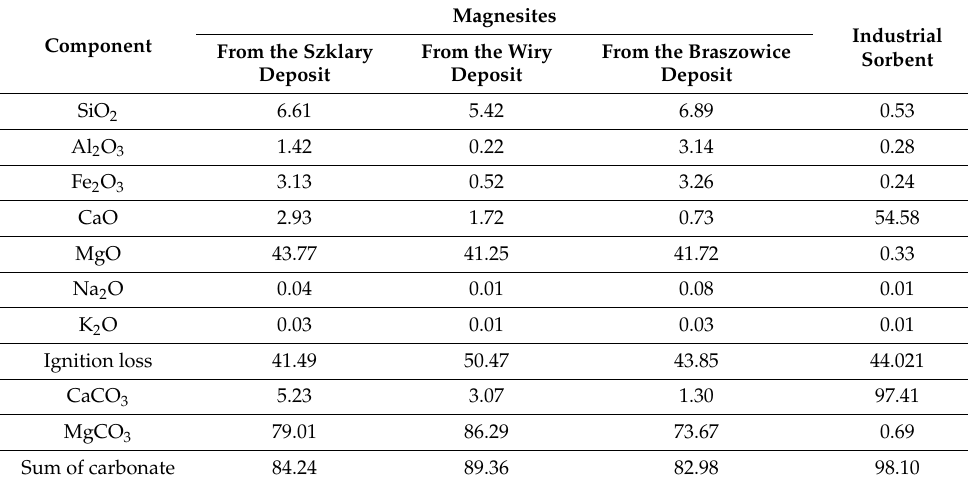
Table 4. Chemical composition of the investigated magnesites [%